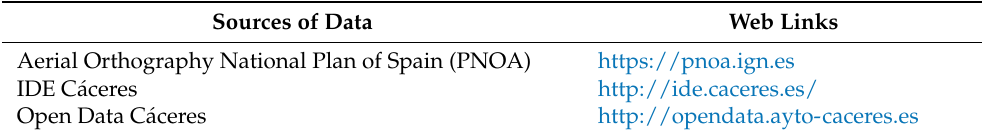
Table 1. Data sources used for analysing sustainability indicators. Sources of Data Web Links Aerial Orthography National Plan of Spain (PNOA) https://pnoa.ign.es IDE C á